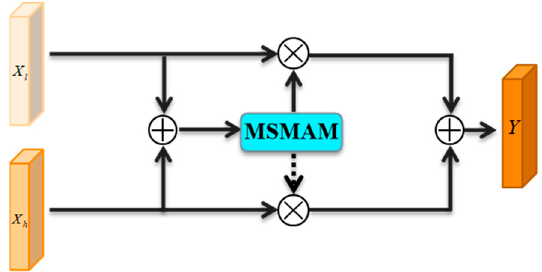
Figure 10. MAFF structure.